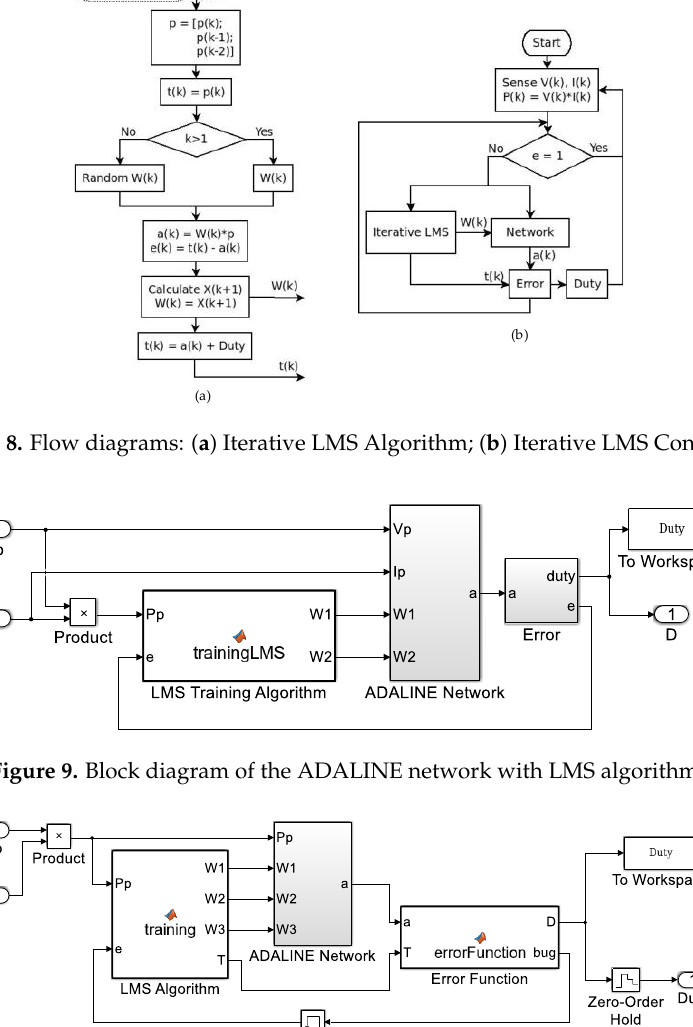
Figure 9. Block diagram of the ADALINE network with LMS algorithm.